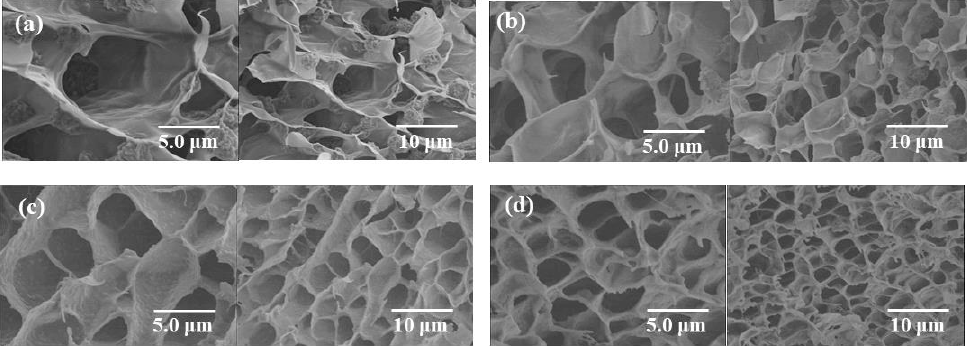
Figure 5. SEM images of ( a – d ) lyophilized products of runs 1–4.